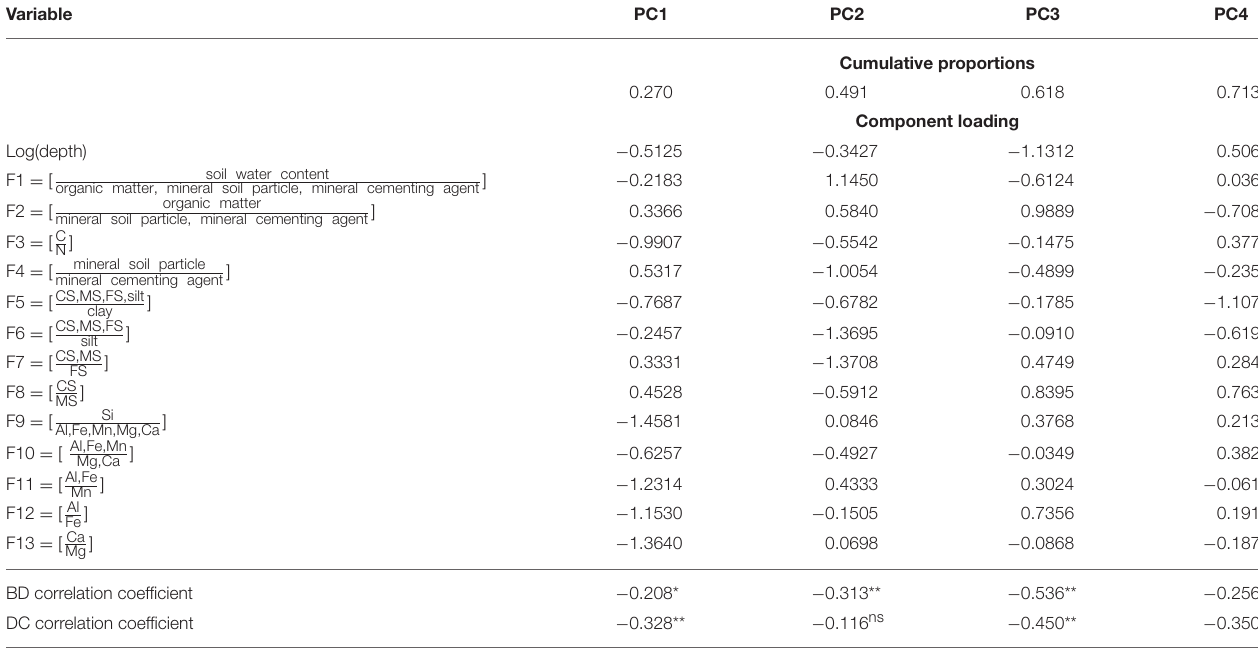
TABLE 1 | Results of principal component analysis and loadings of component for soil bulk density and the degree of compaction. Variable